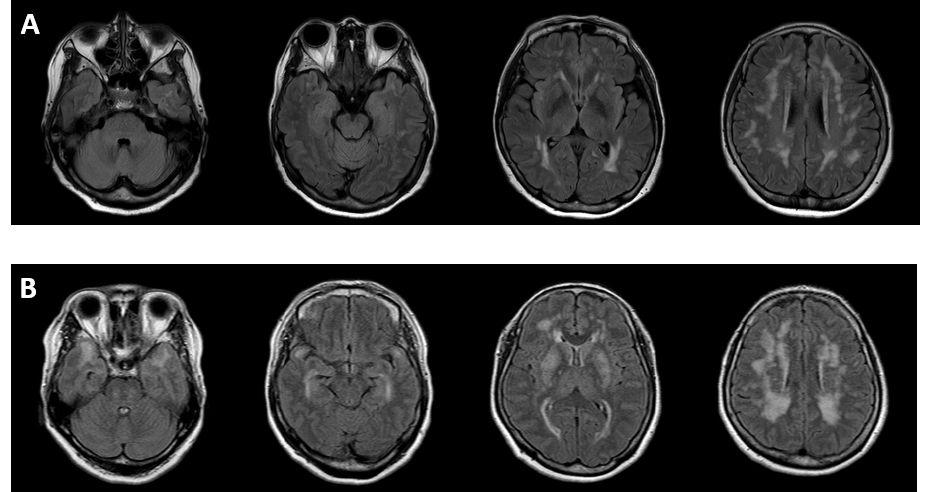
Figure 2. Anterior temporal pole involvement according to cysteine-sparing or cysteine-related mutations. ( A ) cysteine-sparing (R75P mutation in exon 3); ( B ) cysteine-related (C542R mutation in exon 11).